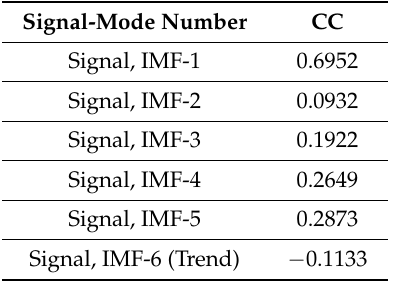
Table 5. Correlation Coefficient (CC) values of the DMI modes and the signal derived from Dataset-1. Signal-Mode